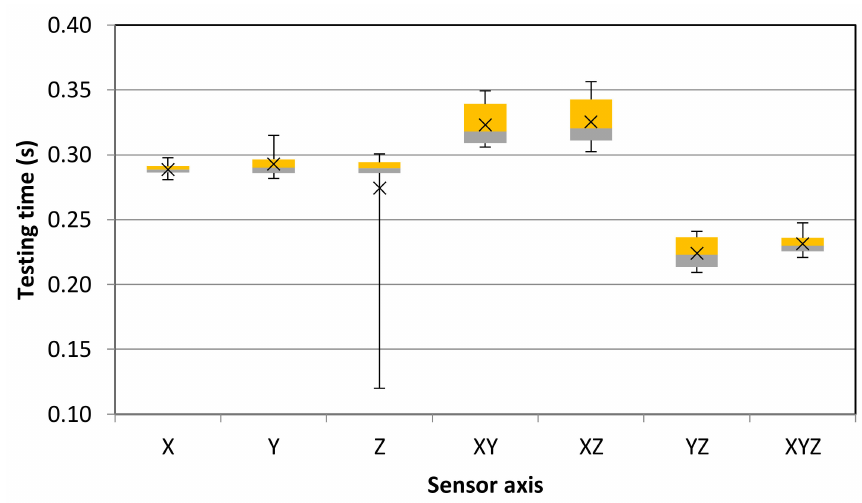
Figure 22. Box plot of ‘testing time’ for all sensor axis of the accelerometer.